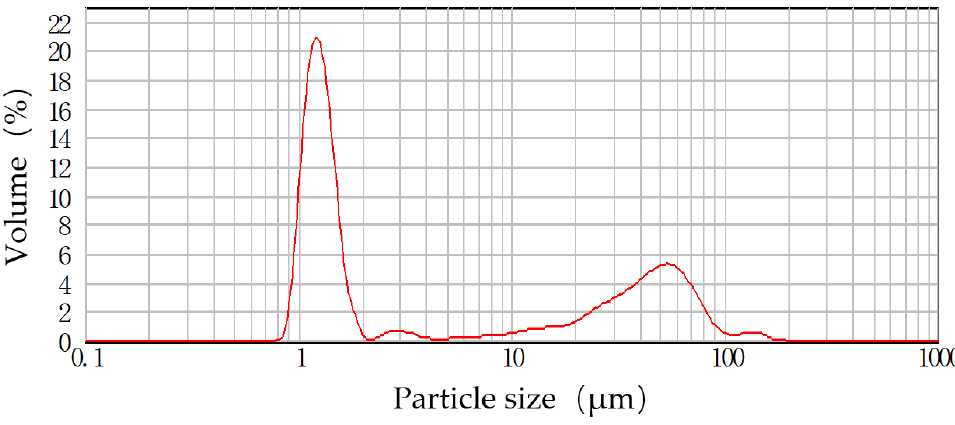
Figure 10. SEM images of SiC sample #2: ( a ) 2000 times; ( b ) 100,000 times.